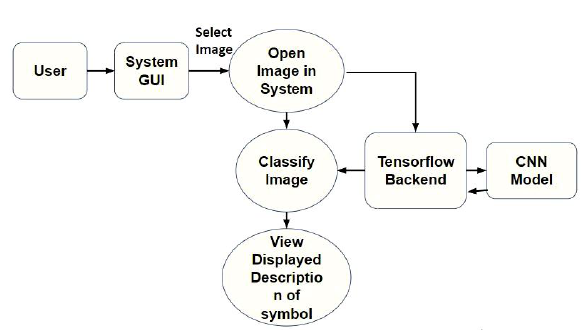
Fig. 3. Proposed System Diagram For Classification of Static Images